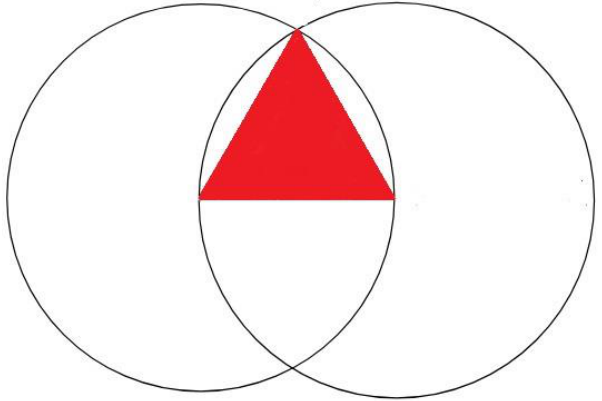
Figure 1. The First Proposition from Euclid’s Elements , the inspiration for the ALP diagram in Finnegans Wake . The ovoid shape formed by the overlapping circles is the vesica piscis.